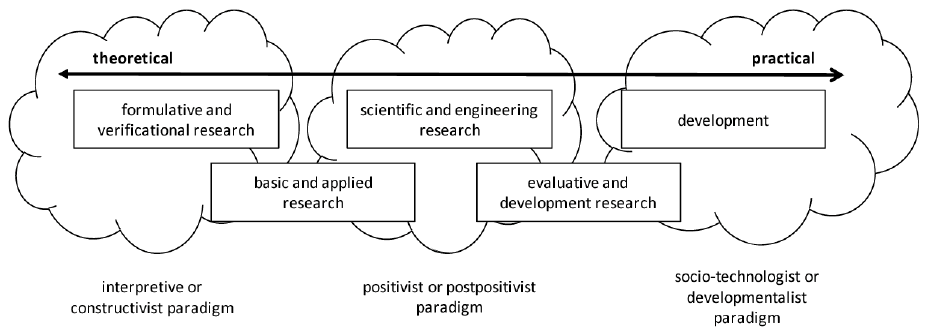
Figure 6. Research paradigm [30].